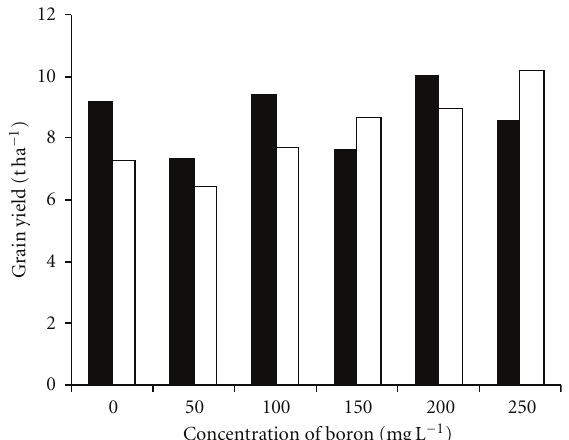
Figure 6: E ff ect of foliar applied boron on grain yield (t ha − 1 ) in Spring (filled columns) and autumn (open columns) sunflower crops. (LSD 0 . 05 0.738 and 1.507,